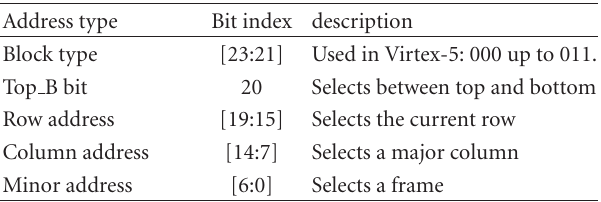
Table 1: Frame address register description (Xilinx